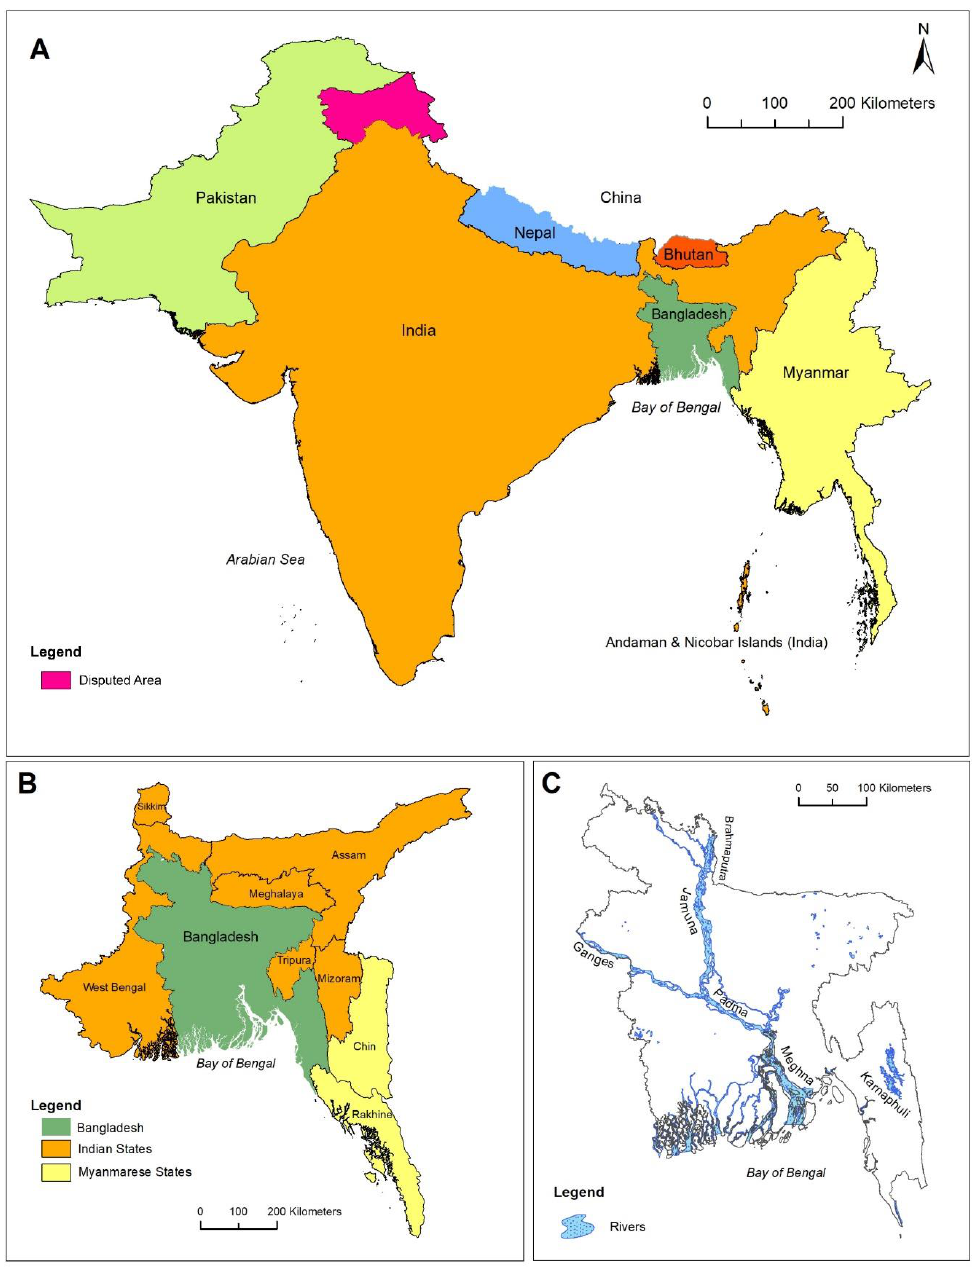
Figure 1. Maps of the study countries and regions. ( A ) Map showing the countries of the Indian subcontinent where Bangladesh is surrounded by India on the east, north and west of the country, and Myanmar on the southeast corner of Bangladesh. ( B ) The study regions/states that are adjacent to Bangladesh. ( C ) Map of Bangladesh showing the three big rivers, i.e., Jamuna, Padma, and Meghna that distinctly divide the country into east and west.